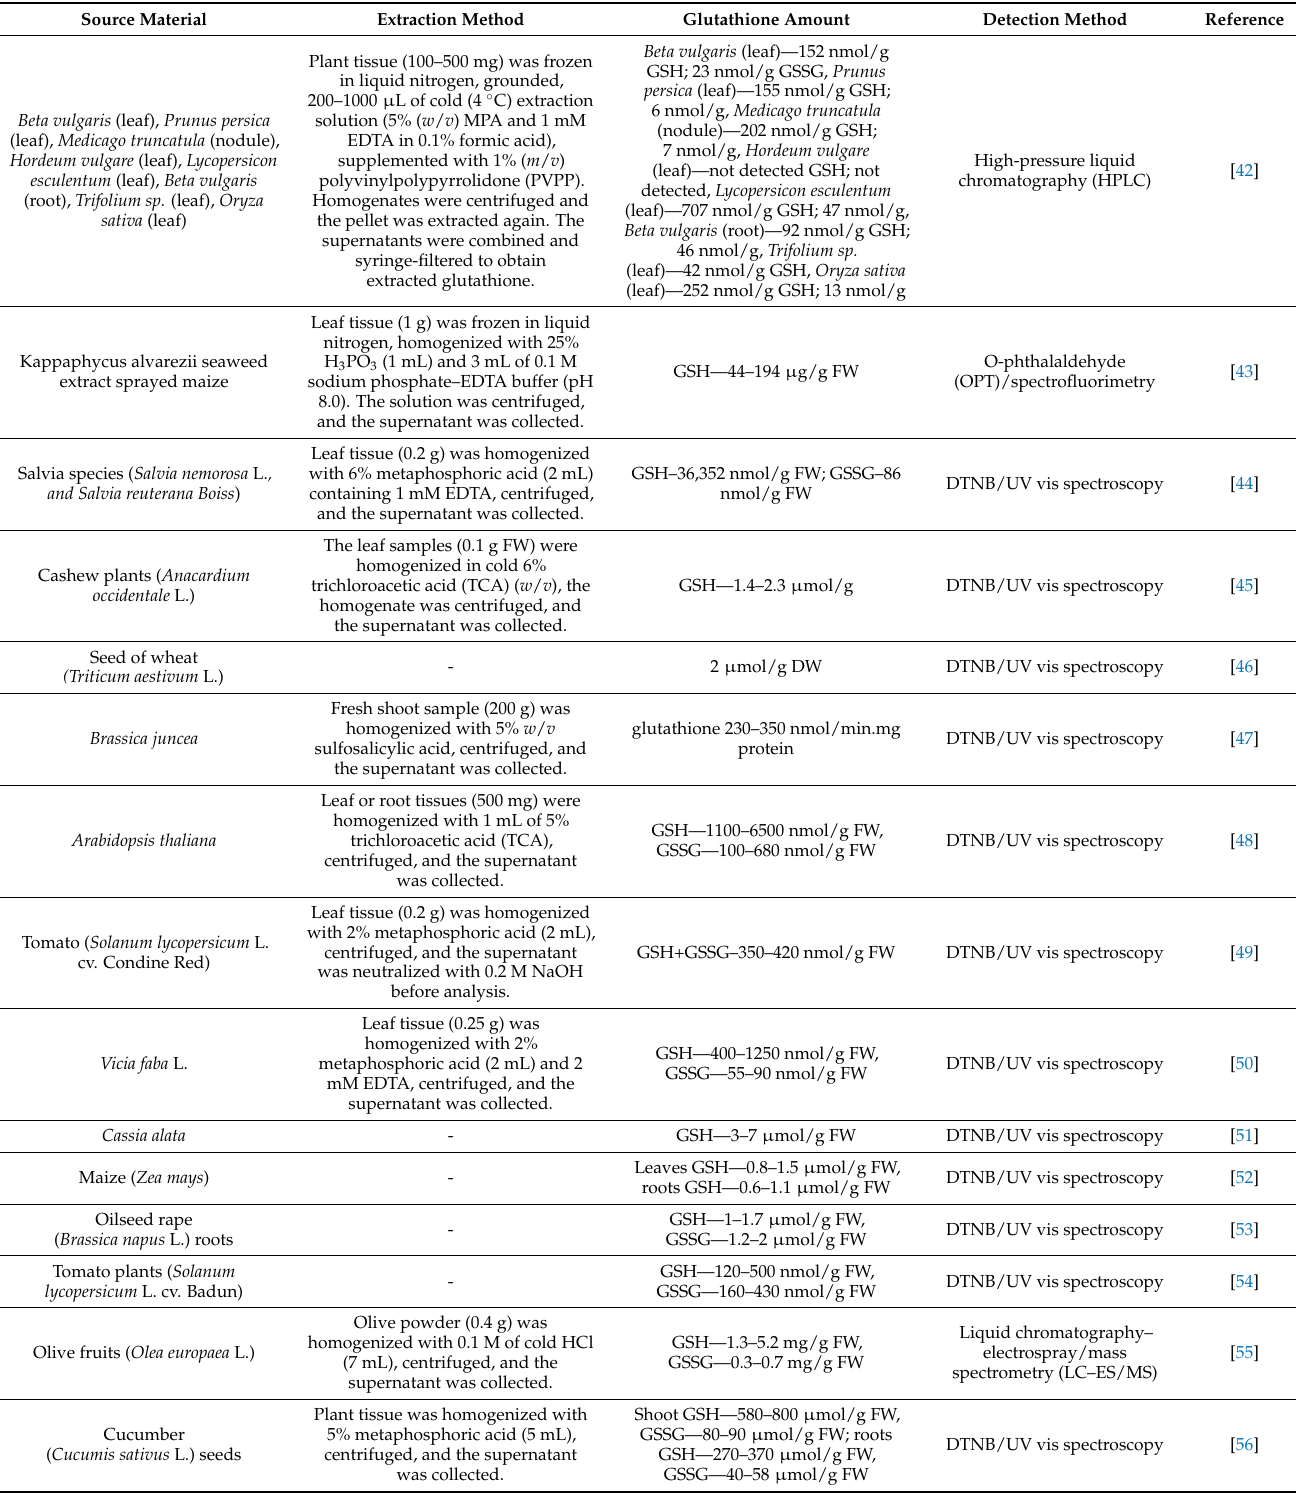
Table 1. Detailing different sources of glutathione, extraction methods, type, and amount of glu- tathione and detection